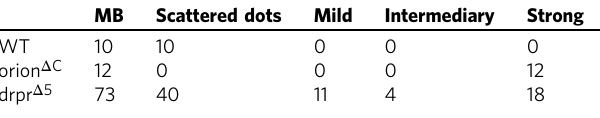
Genotypes are indicated on the left. “ MB ” indicates the number of mushroom bodies observed for each genotype. Unpruned axons were ranked into three categories: “ None ” indicates the absence of unpruned γ axons and “ Weak ” and “ Strong ” refer to different levels of the mutant pruning phenotype. Axon debris were ranked into fi ve categories: “ None ” indicates the absence of debris and “ Scattered dots ” means that some individual debris can be observed. “ Mild, ” “ Intermediate, ” and “ Strong ” refer to different levels of debris (see Supplementary Fig. 2 and “ Methods ” ). Full genotypes are listed in the Supplementary list of fl y